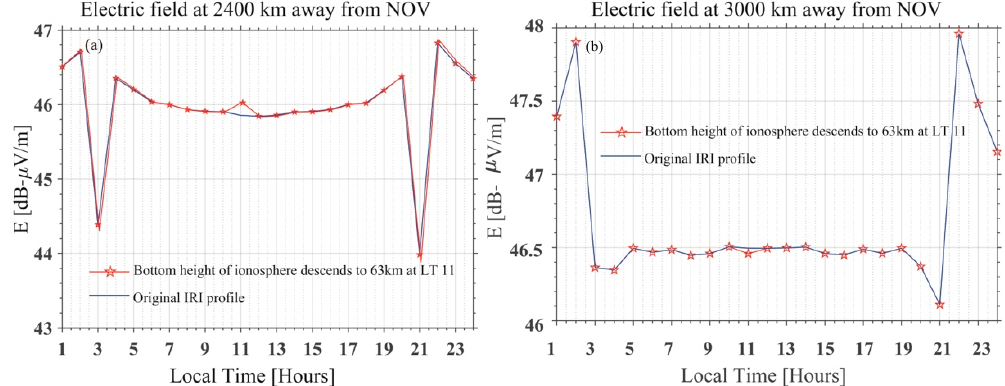
Figure 14. The figure shows the calculated Ez component of the electric field 2400 km ( a ) and 3000 km ( b ) from the NOV transmitter at 11.9 kHz. In ( a ), the blue solid line shows the simulated result under the original IRI profile; the red solid line with pentagrams shows the simulated result when the bottom height of the ionosphere descends at LT 11:00 2400 km from the NOV transmitter. In ( b ), the blue solid line shows the simulated result under the original IRI profile; the red solid line with pentagrams shows the simulated result when the bottom height of the ionosphere ascends at LT 11:00 3000 km from the NOV transmitter.